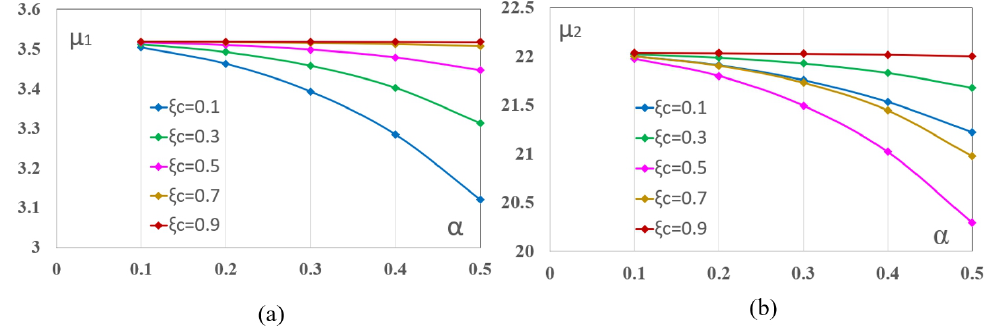
Figure 6. Dimensionless frequency for different values of α and ξ c ( r = 0.2, S L = 120 and Ω = 6 rad/s). ( a ) µ 1 and ( b ) µ 2